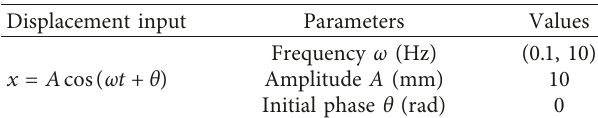
Table 2: Test input parameters.